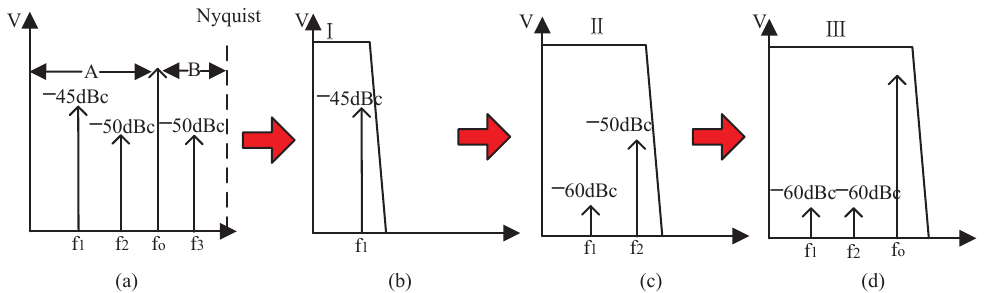
Figure 2. Operating flow of spur detection and reduction: ( a ) dividing the frequency by f o , ( b ) filtering and spur detection of f 1 , ( c ) reduction of f 1 and detection of f 2 , ( d ) reduction of f 2 and remove f 3 by off-chip